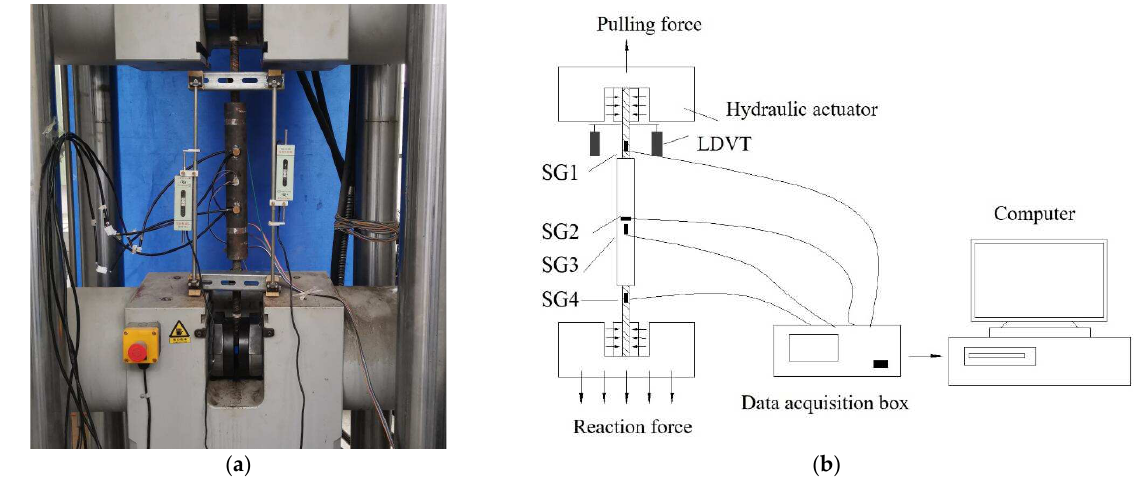
Figure 5. Test setup. ( a ) Loading device. ( b ) Measurement program. Table 4. Tensile results and failure modes.